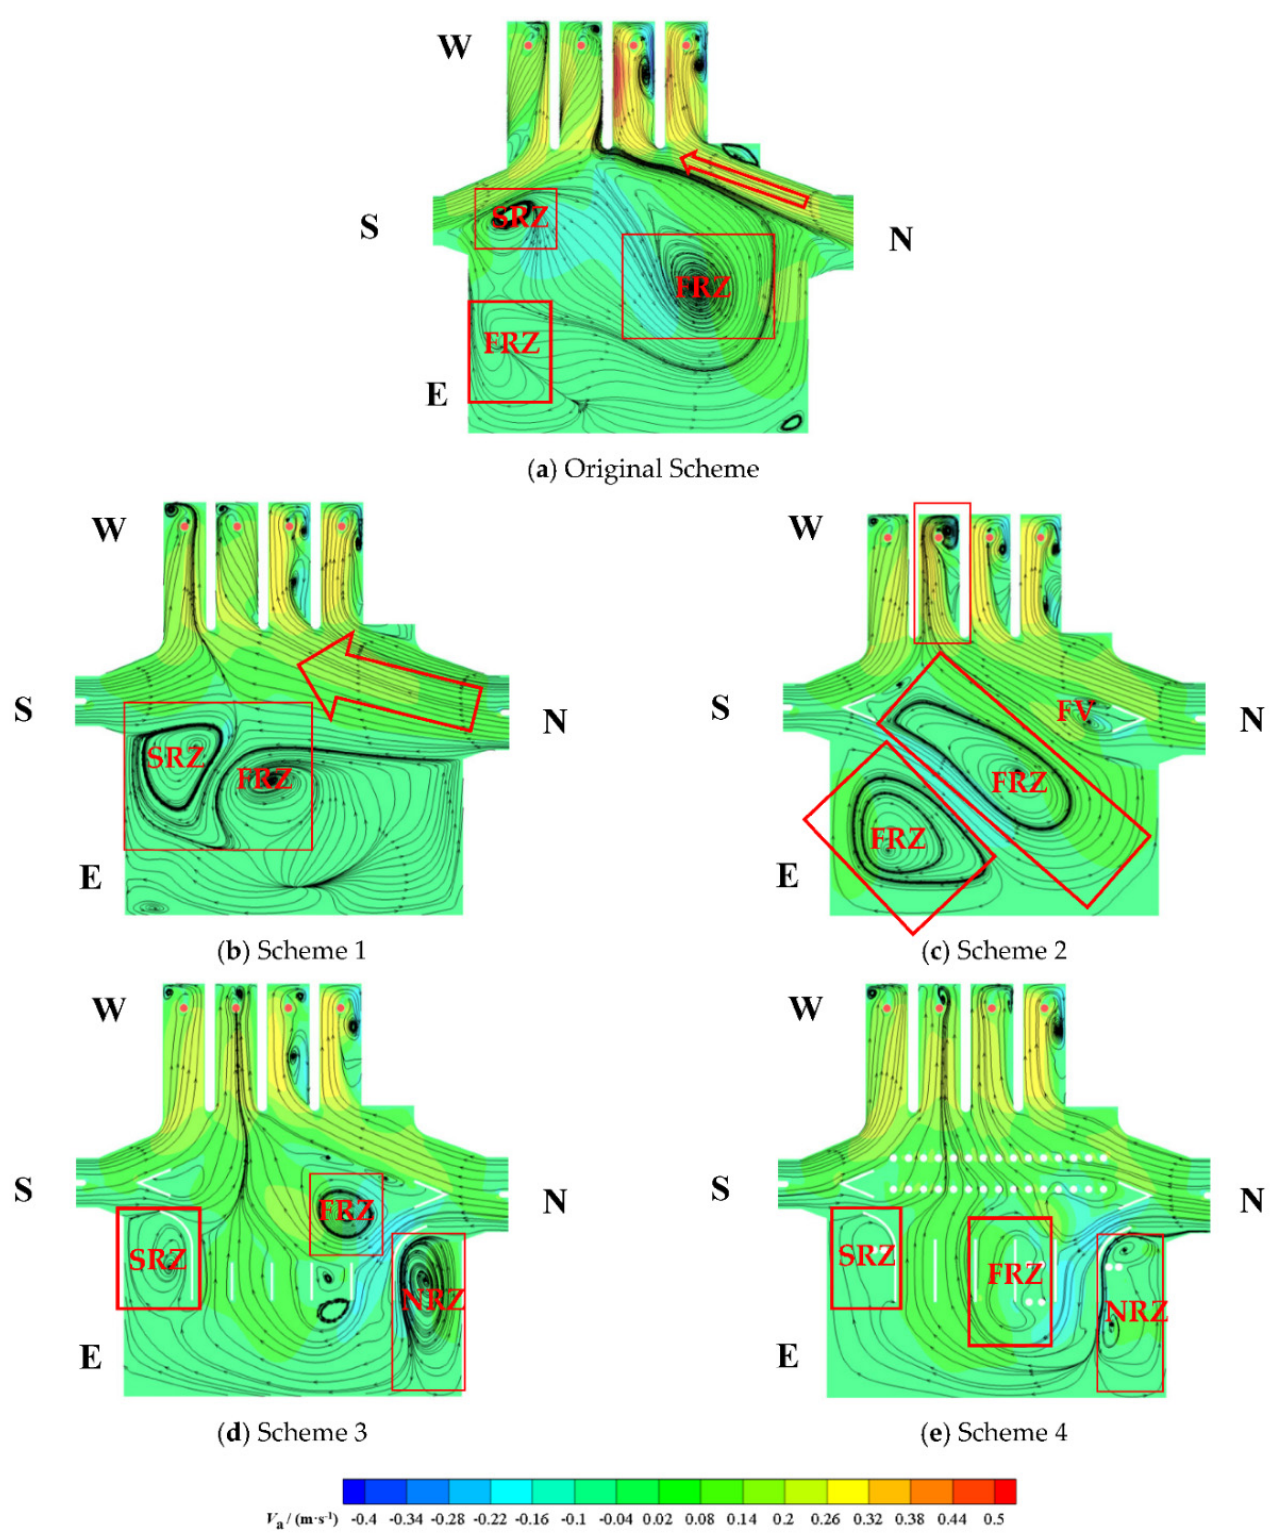
Figure 9. Bottom streamline and axial velocity contour